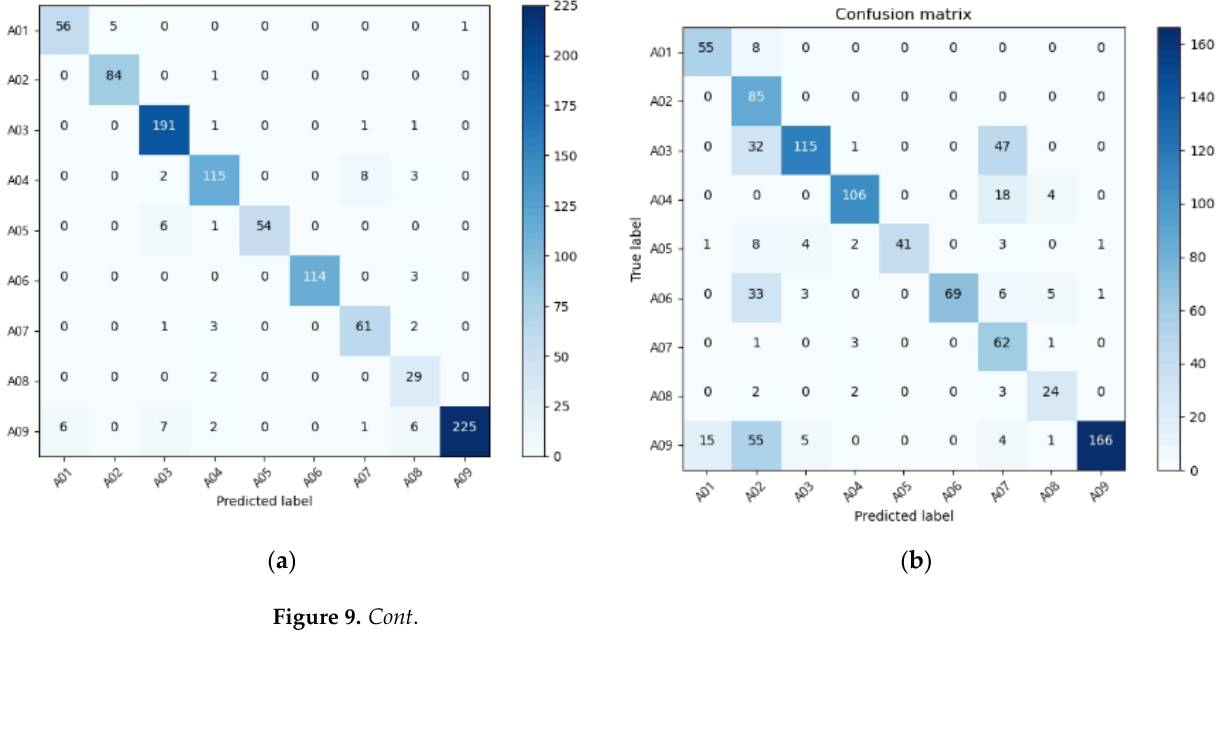
Figure 8. Input data distortion: ( a ) adding Gaussian noise to one channel of an accelerometer sensor and ( b ) a flipped image from left to right, bottom to top.